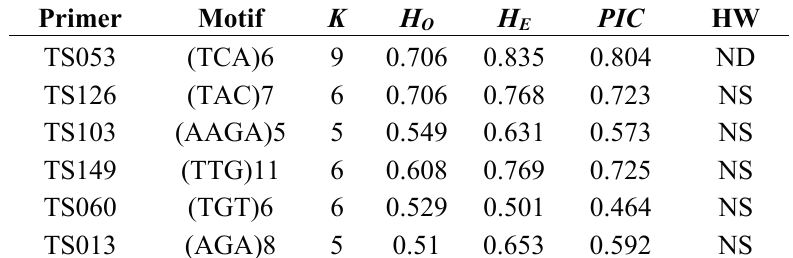
Table 3. Characteristics of the six primer pairs used for the phylogenetic analysis of the 51 individuals. Primer Motif K H